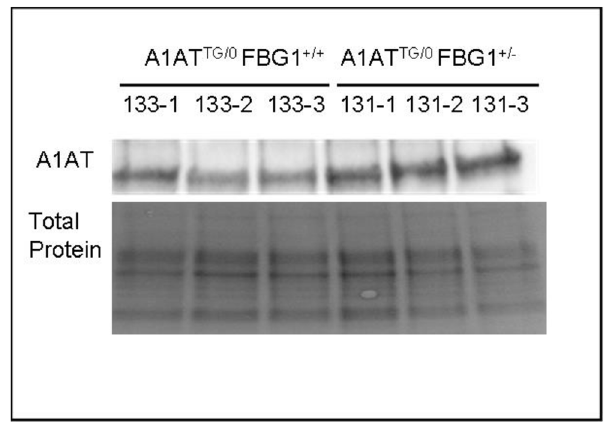
FBG1 is a member of the SKP1/CUL1/F-box (SCF) family of ubiquitin ligases. In the SCF com- plex, the F-box protein is the substrate-binding member. Most F-box proteins have a bipartite structure containing the relatively invariant F-box motif that recognizes SKP1, and the highly variable C-terminal domain, which recognizes specific substrates. We have previously shown that FBG1 binds SKP1 and forms an SCF complex [30 – 32].